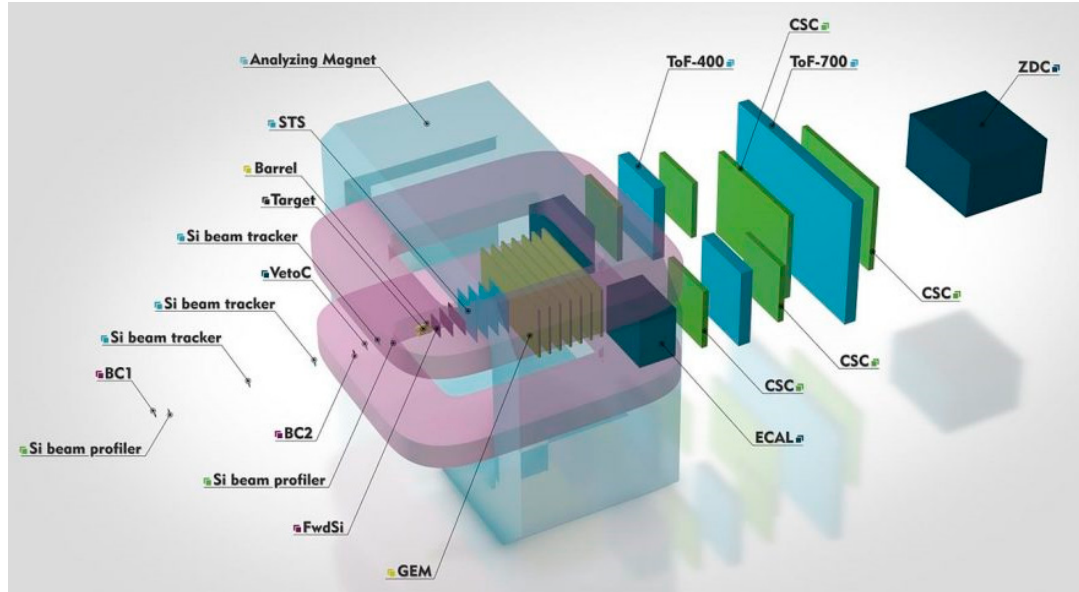
Figure 3. Sketch of the Baryonic Matter at the Nuclotron (BM@N) experiment with its various detector systems.